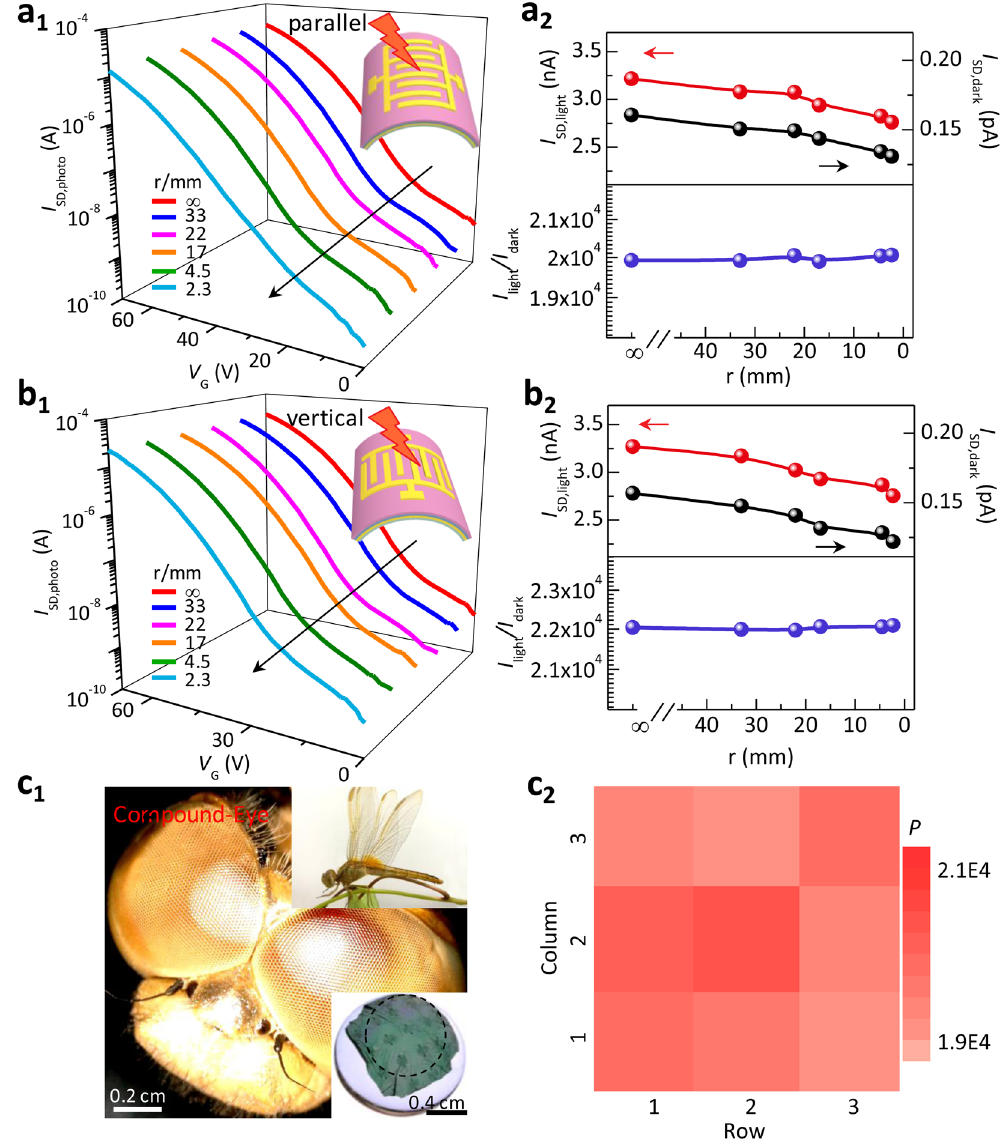
Figure 6. Photoresponse performance of the conformal PTCDI-C 13 H 27 phototransistor array on different curved objects. ( a 1 , a 2 , b 1 , b 2 ) Typical photograph and schematic images (inset), typical transfer characteristics under illumination, I light , I dark and I light /I dark of the device at strain bending parallel and vertical to channel length, respectively. The bending radius is from 3.3 to 0.23 cm. ( c 1 ) Optical microscopy image of the compound eyes from a real dragonfly eye. The right-bottom optical microscopy image in the inset shows a real device array adhered on a hemisphere lens with the bending radius of 0.64 cm. ( c 2 ) Photosensitivity mapping with a 3 × 3 OPT array as shown in the inset of Figure c1. The wavelength of illumination is 489 nm and light power density is 100 μ W cm − 2